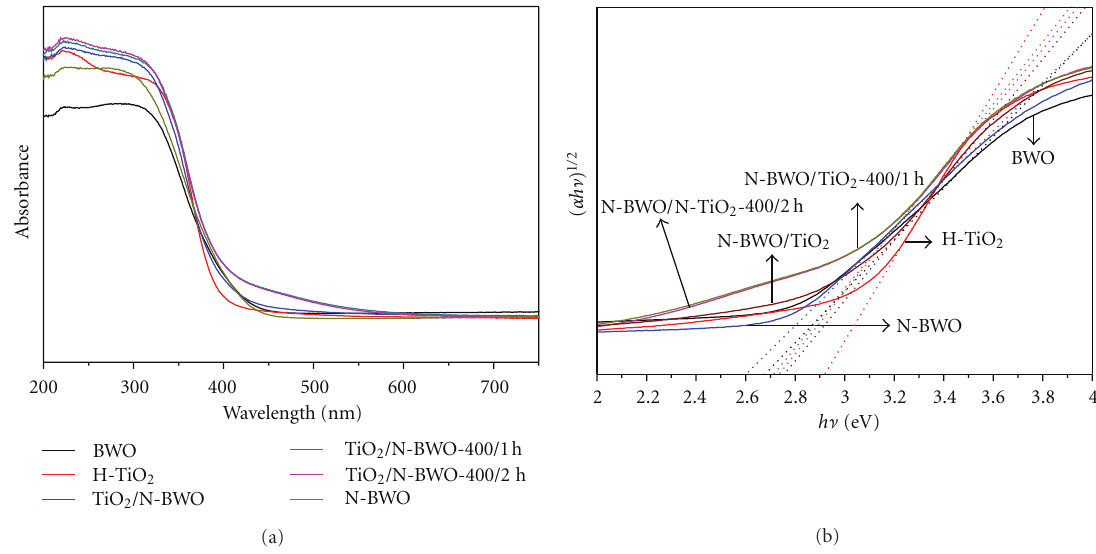
Figure 5: (a) UV-vis di ff use reflectance spectra for the as-synthesized samples. (b) The relationship between ( ahv ) 1 / 2 and photon energy.